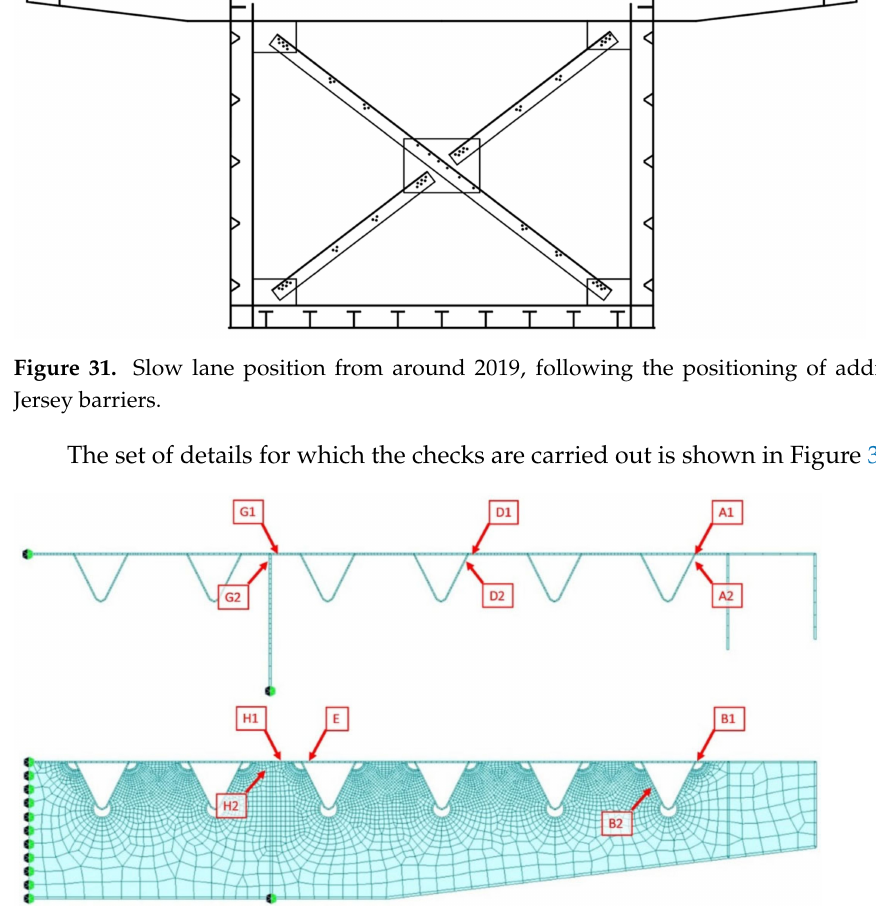
Figure 32. Details subjected to assessment from the section 7.36 m from the first rib (mid-span of the rib) and 6.00 m from the first rib